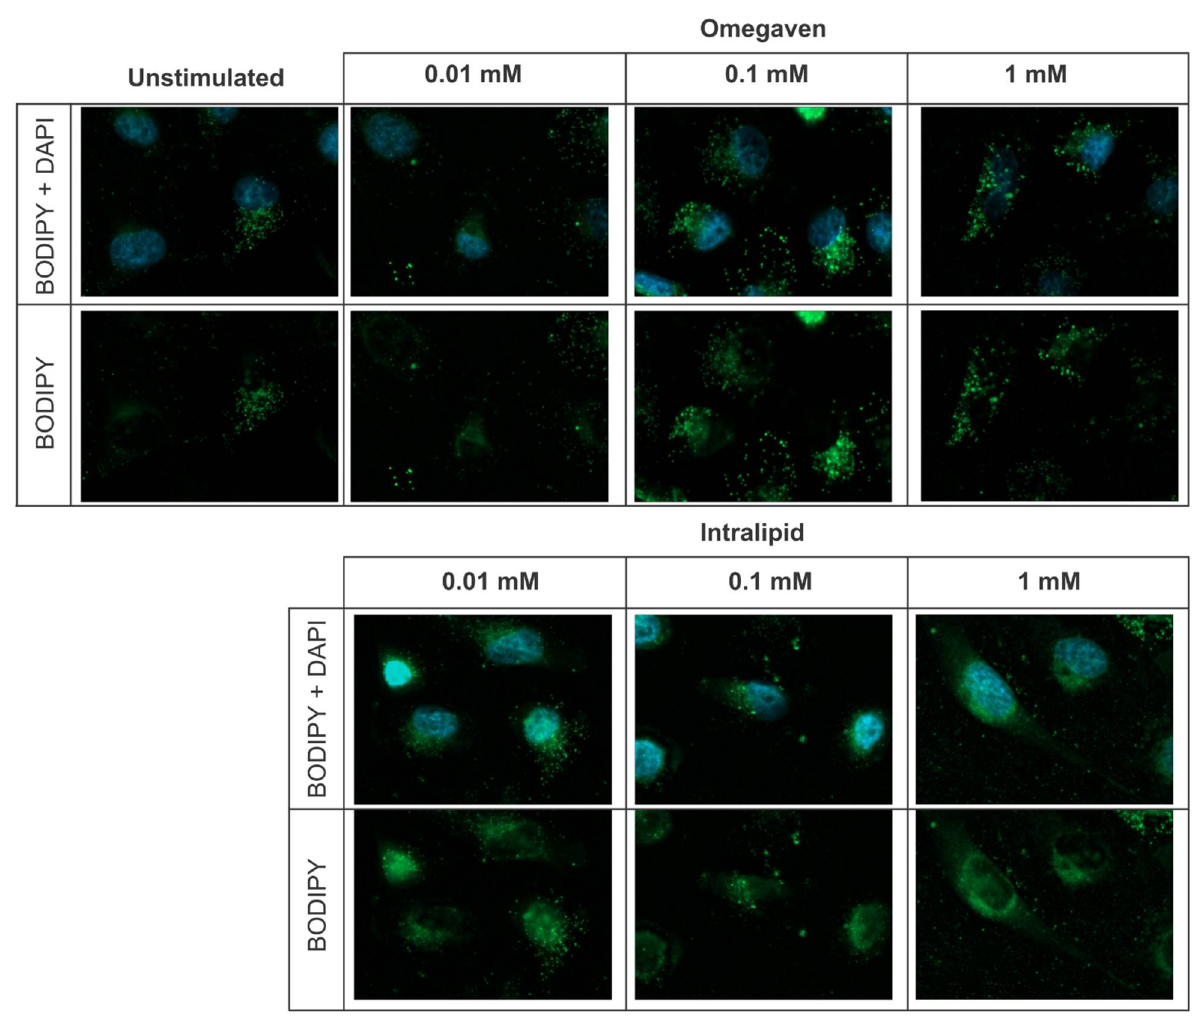
Figure 1. Endothelial cells uptake Omegaven ® and Intralipid ® emulsions. Endothelial cells were stimulated with 0.01, 0.1, or 1 mM Omegaven ® or Intralipid ® emulsions for 24 h, and intracellular lipid droplet uptake were measured by BODIPY 493/503 dye staining.